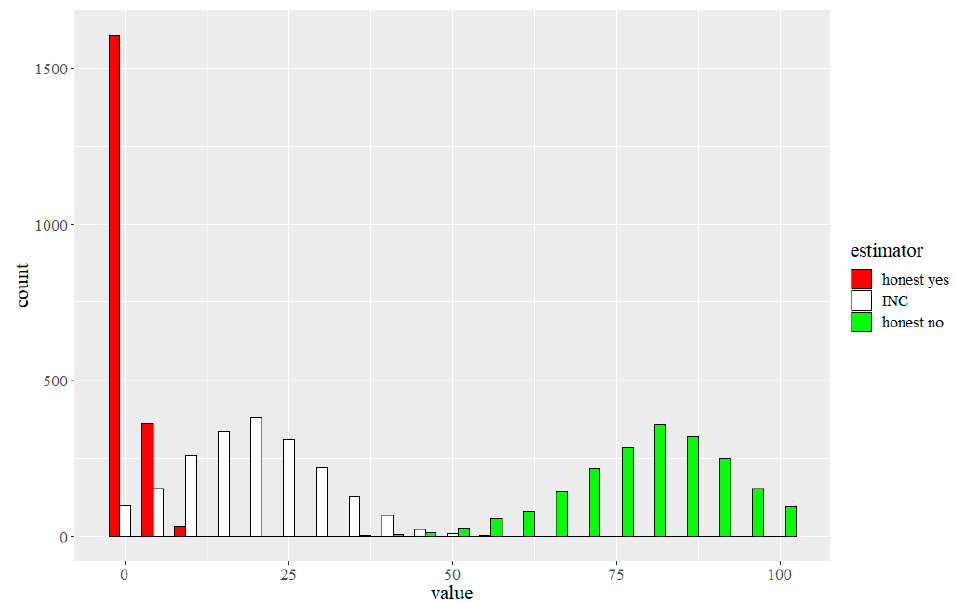
Figure 2. Skewed distributions of RRT estimators from 2000 bootstrap-replications for assumed true scores close to zero (honest yes) and due to the ‘trade-off’ of answers between INC and honest no in cases of estimators above 1 or below zero.